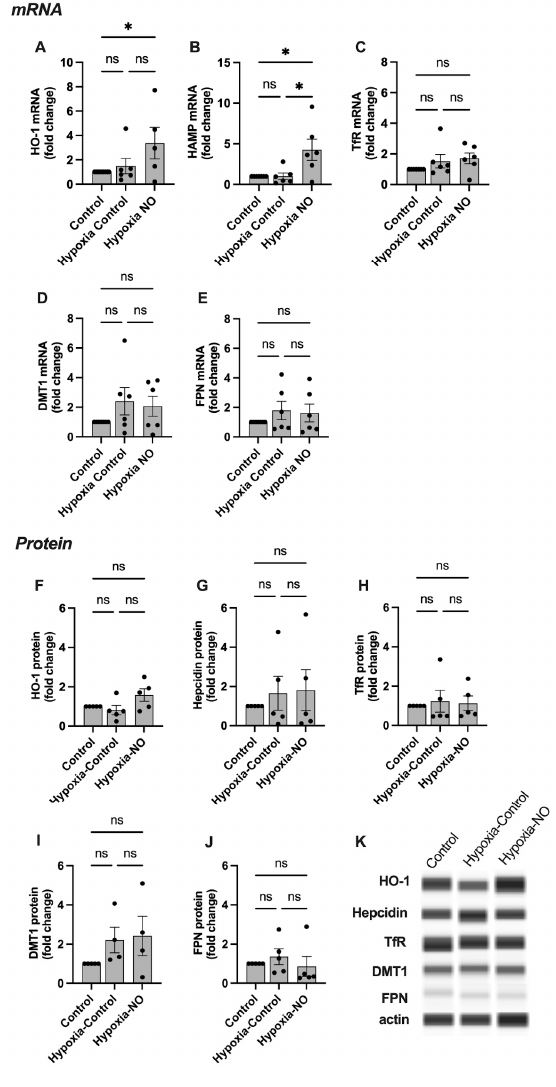
Figure 6. The effect of hypoxia on iron handling genes in response to NO in syncitialized BeWo cells (SCTs). ( A – F ) qPCR results and ( G – K ) protein analyses. Representative blots are shown in ( K ). Hy-